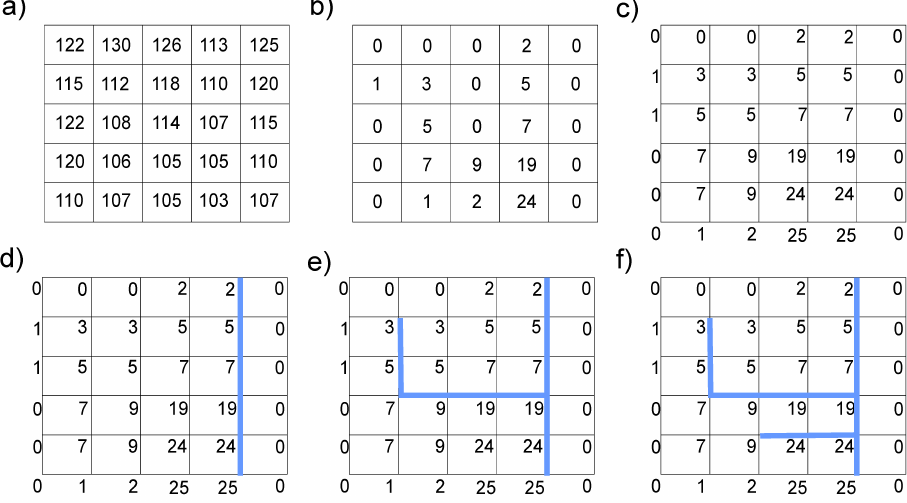
Fig. 2. Automatic generation of river channel network for a 5 by 5 example. (a) DEM data (m), (b) upstream contributing area for each grid cell, (c) upstream contributing area for each cell corner, (d) add first channel, (e) add second channel, (f) add third